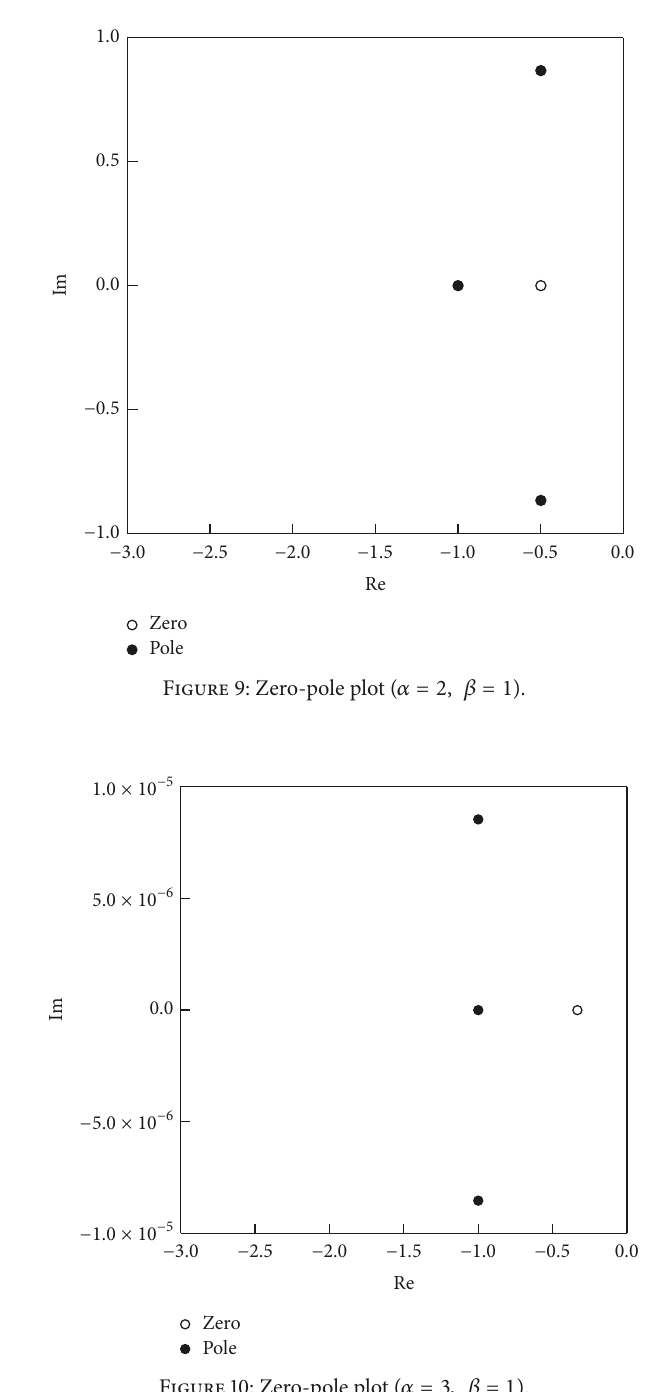
Figure 10: Zero-pole plot ( 𝛼 = 3, 𝛽 = 1